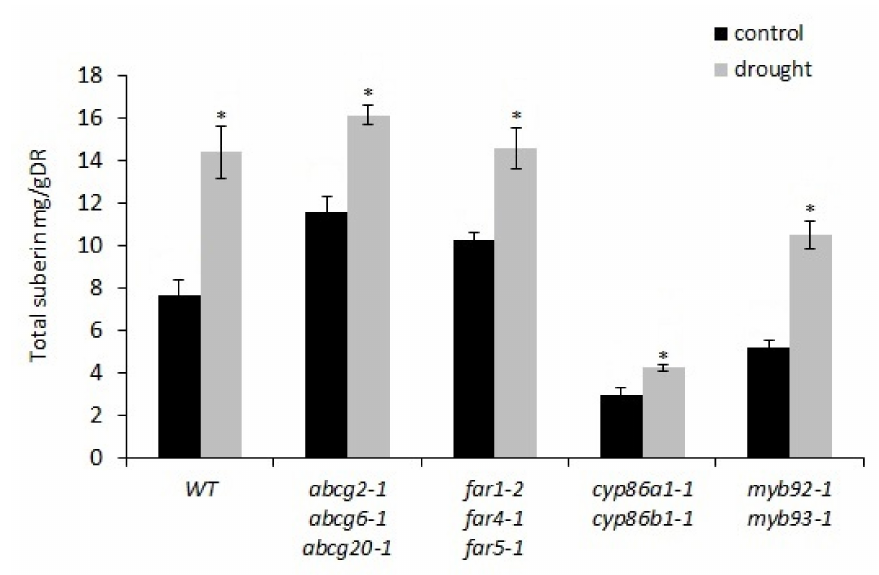
Figure 6. Total poly-aliphatic suberin in roots of wild-type and suberin mutants. Mean values of total suberin are given in milligrams of suberin per gram of delipidated dry residue (DR) from 3–4 replicate samples ± SE. Each replicate consisted of roots from four pooled plants at 4-weeks old. ANOVA results indicated significant interactions between genotype and treatment effects (Table S1). Asterisks indicate significant differences by Student’s t -test at p < 0.05 comparing control and treatment.